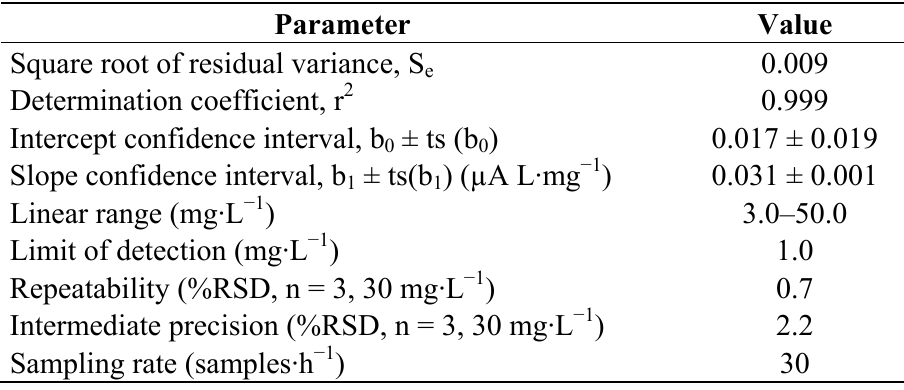
Table 3. Regression values for the calibration plot, peak height (µA) vs. [oxalate] (mg·L − 1